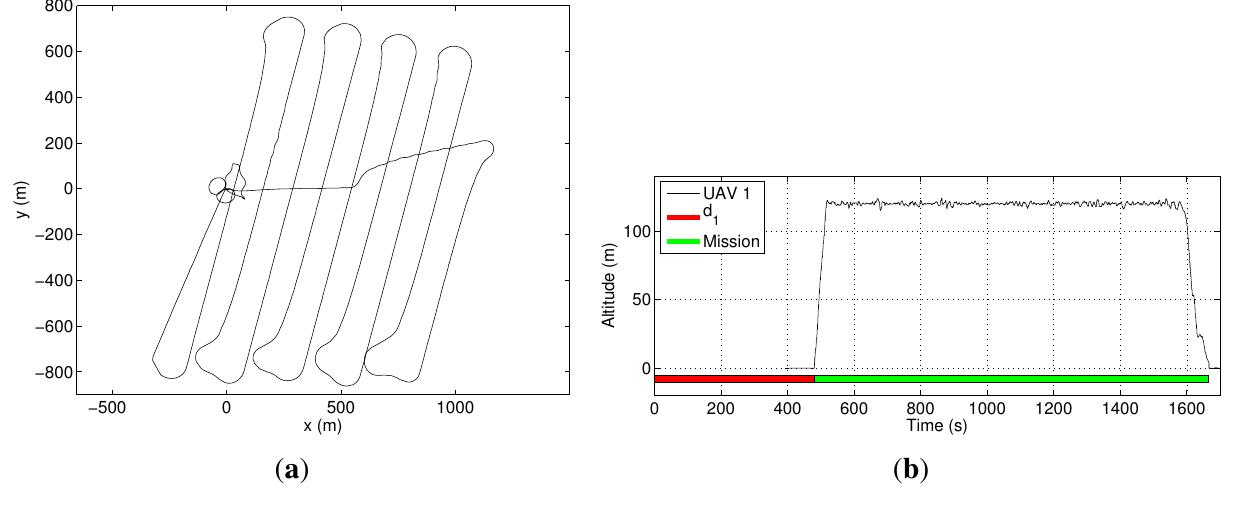
Figure 13. Coverage of the area in Figure 12 with a single UAV. ( a ) The UAV’s path projected on a cartographic reference system; ( b ) the UAV’s altitude. In this figure, d the UAV setup time.